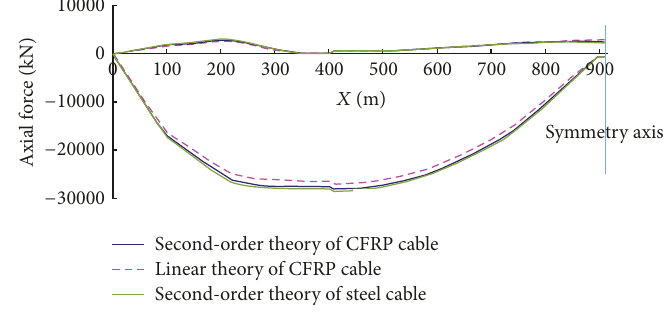
Figure 8: Envelope diagram of girder’s axial forces.